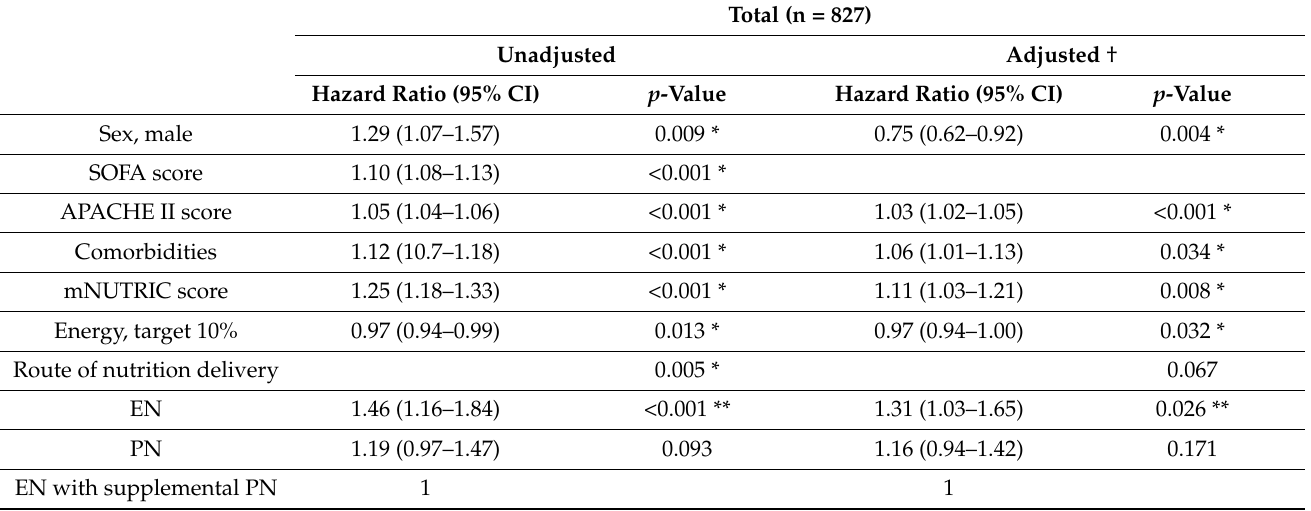
Table 5. Association between nutrition delivery route and 1-year mortality for patients with sepsis or septic shock.